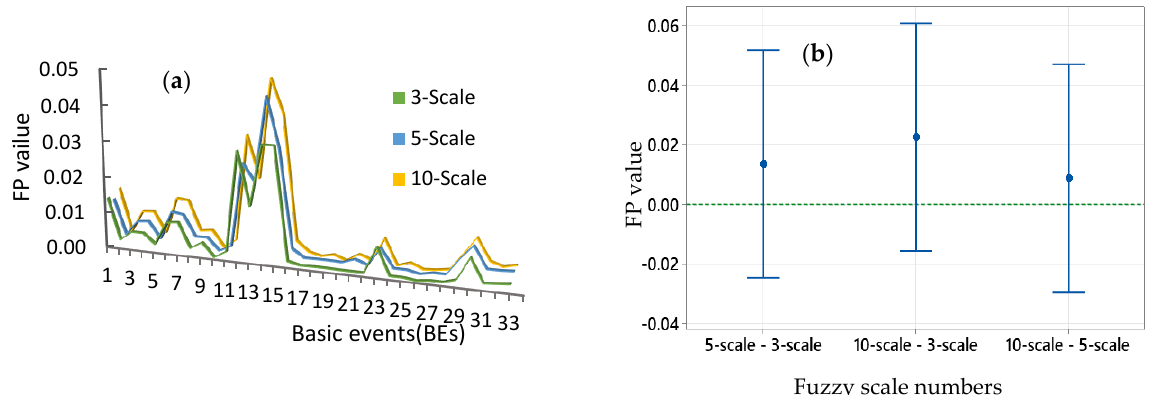
Figure 5. The results of FP for basic events considering the effects of various scales of fuzzy numbers. Additionally, the various defuzzification algorithms were compared to determine the FP of basic events, for which the results are presented in Figure 6a,b. The average values of FP under centroid, bisector, mom, lom, and som defuzzification algorithms were obtained as 0.008, 0.009, 0.010, 0.008, and 0.102, respectively. The comparison mean test shows that there is no significant difference between the defuzzification algorithms for predicting the FP, statistically ( p value > 0.05). Since, in FFTA model, the effect of various attributes, such as the scales variation and assorted membership, and the defuzzification functions were not statistically significant, the average values can be considered to esti- mate the FP of basic events in the fluid filling system. Figure 6. The results of FP for basic events considering the effects of defuzzification algorithms. Moreover, due to the static structure assumption of the FFTA model throughout the estimation of the FP of basic events, the Bayesian mechanism was employed to consider all possible dynamic interactions between the components. The FFTA model was mapped into the BN structure, shown in Figure 7. In this BN, G.1 was a leaf node that corresponded to the TE of the FTA model, and G.2 to G.16 were the intermediate nodes associated with the intermediate events of the FTA model, in which the conditional probability values of each node were occupied based on the type of logic gates (state = 0 means faulty, state = 1 means healthy) using GeNIe 3.0 software (Figure 8).